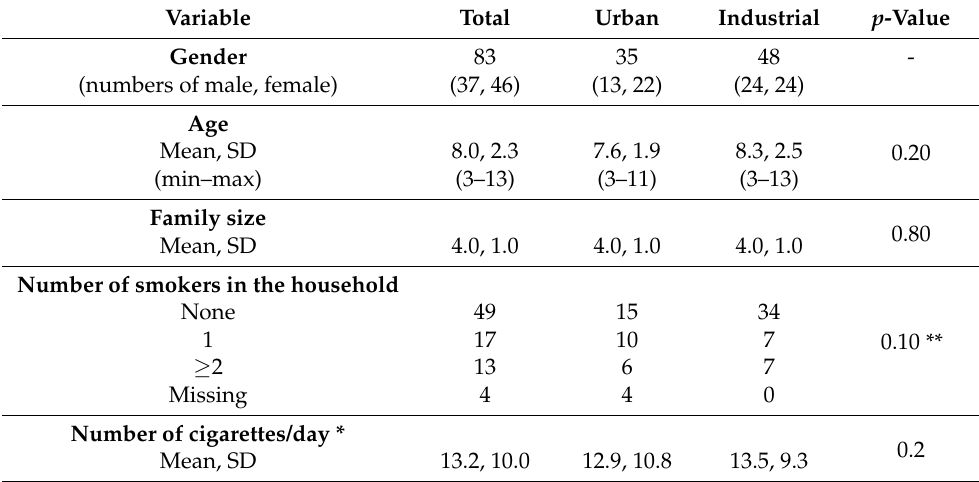
Table 2. Resident population, motorization rate, and annual mean airborne level of benzene and PM2.5 in the two study areas.